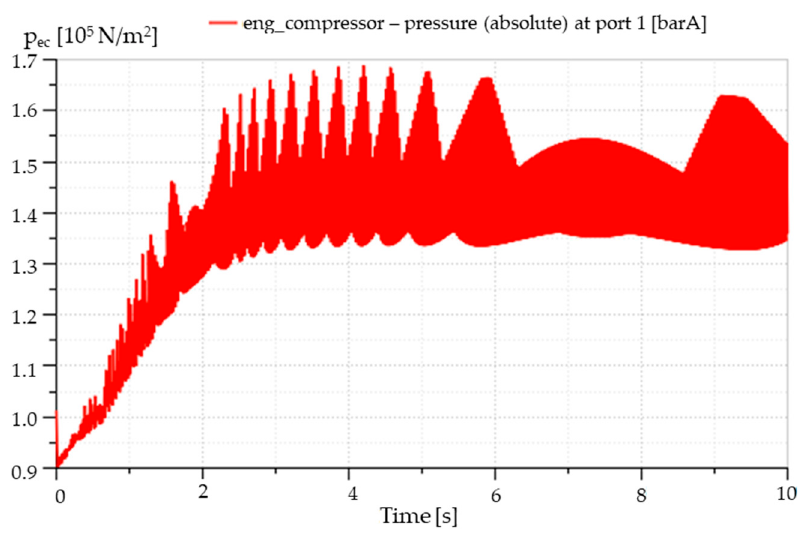
Figure 16. Variation of compressed air pressure simulated with AMESim software.